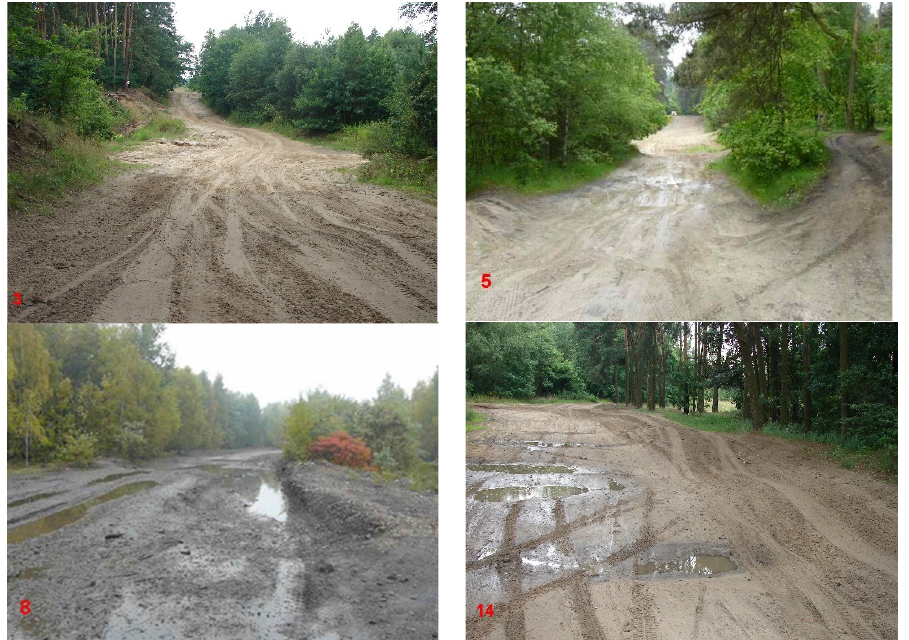
Figure 5. Examples of off-road test sections (3, 5: sandy roads; 8, 14: gravel roads).